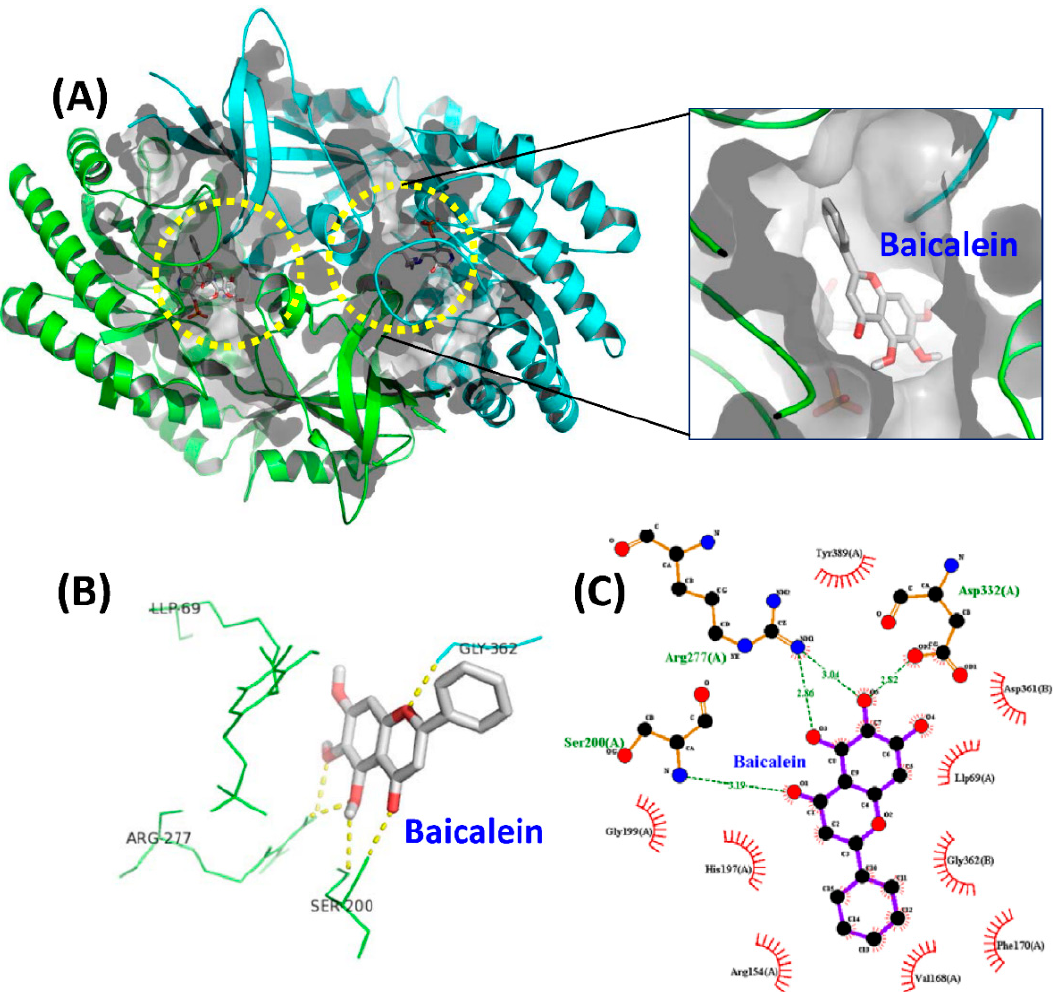
Figure 4. Molecular docking simulations of the ODC dimer with baicalein. ( A ) The best docking result of the ODC dimer with baicalein. The yellow circle indicates the binding pocket of baicalein. ( B ) Ligand interaction diagram of ODC with baicalein. ( C ) Ligand interactions between baicalein and ODC were drawn by the LigPlot program [41]. The green dotted line represents a hydrogen bond. Hydrophobic interaction contributions from nonligand residues are indicated by open spokes.